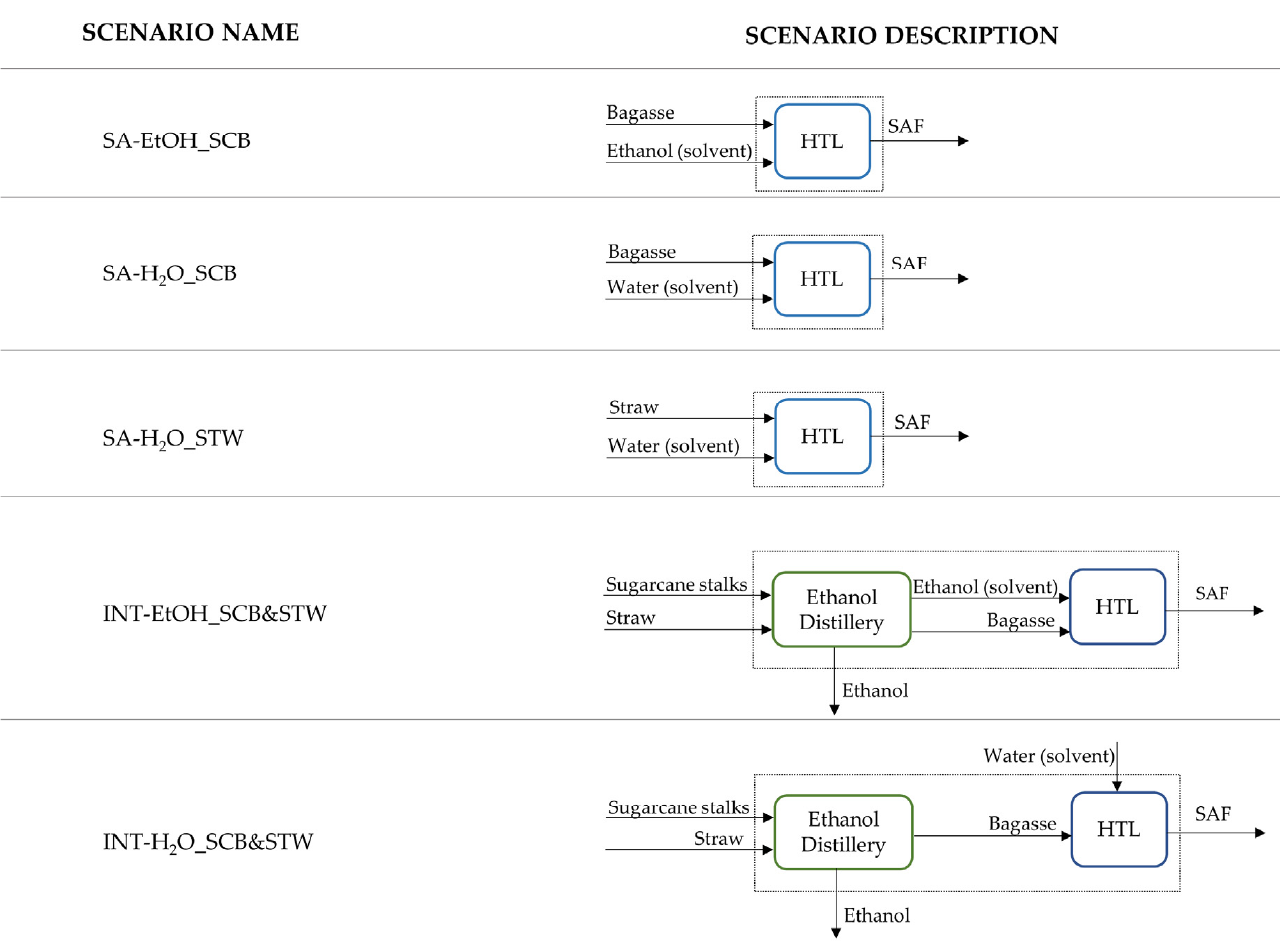
Figure 1. Simplified fluxograms of the proposed scenarios. Solvent varies according to each scenario: for SA-EtOH_SCB, the solvent is anhydrous ethanol (purchased from surrounding mills) and for the INT-EtOH_SCB&STW scenario, ethanol is diverted from the distillery that is integrated into HTL plant. For the SA-H 2 O_SCB, SA-H 2 O_STW, and INT- H 2 O_SCB&STW scenarios, the solvent is